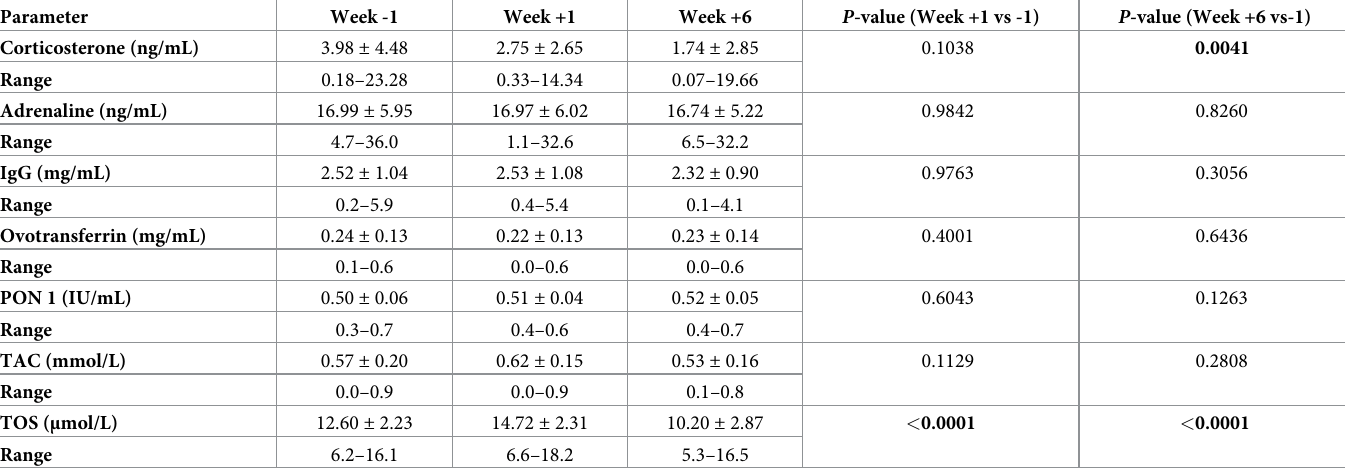
Table 4. Means ( ± standard deviations) and ranges of blood physiological parameters before and after medication with fluralaner, administered in weeks 0 and 1. Parameter Week -1 Corticosterone